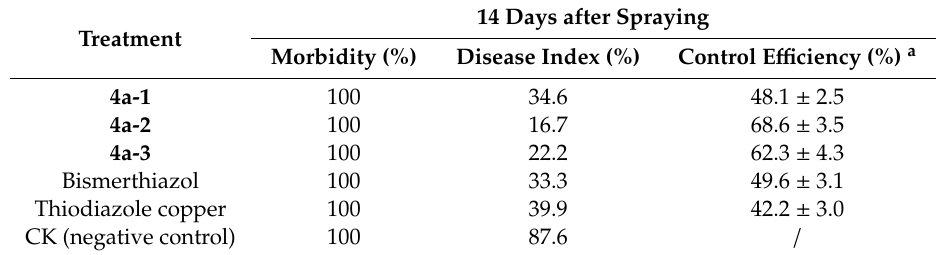
Figure 2. Protective activity of compounds against Xanthomonas orzae pv . oryzae under greenhouse condition. Table 3. Protective e ff ect of compounds 4a-1 , 4a-2 and 4a-3 against Xanthomonas oryzae pv. oryzae Table 4. Curative effect of compounds 4a-1 , 4a-2 and 4a-3 against Xanthomonas oryzae pv. oryzae .